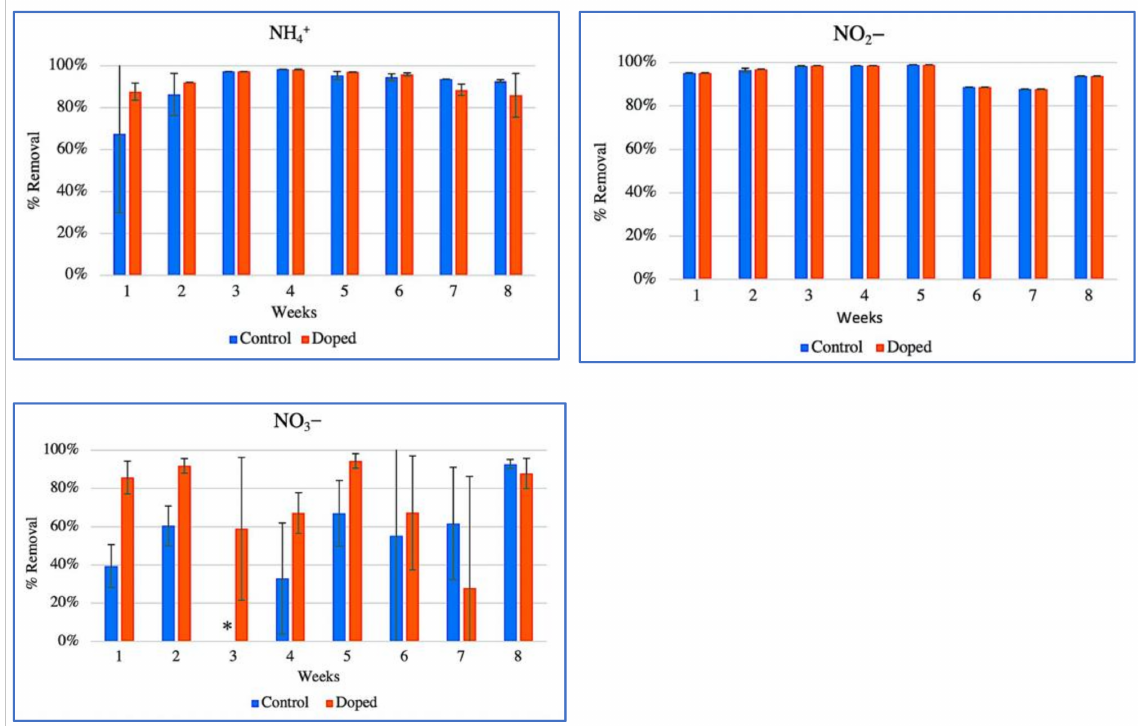
Figure 3. Removal percentage (%, mean and standard deviation, n = 3) of ammonia (NH 4+ ), nitrite (NO 2 − ) and nitrate (NO 3 − ) ions in CWs, irrigated for eight weeks with Ribeira de Joane water not doped (control) or doped with PCP. * no NO 3 − removal in